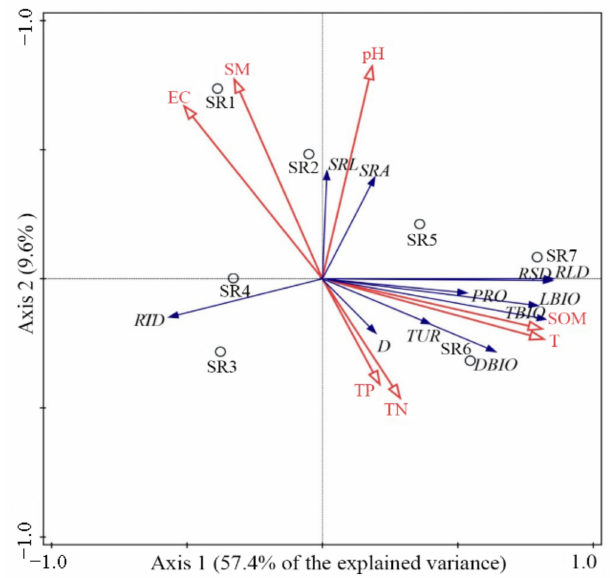
Figure 4. RDA dimensional sequencing